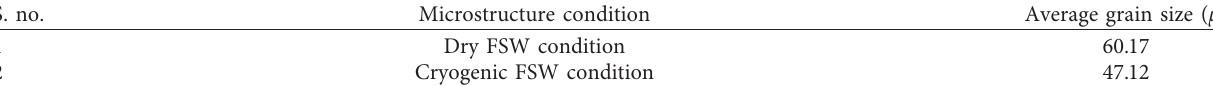
Table 11: Average grain size of the best and worst sample (using “image J” software). S. no.